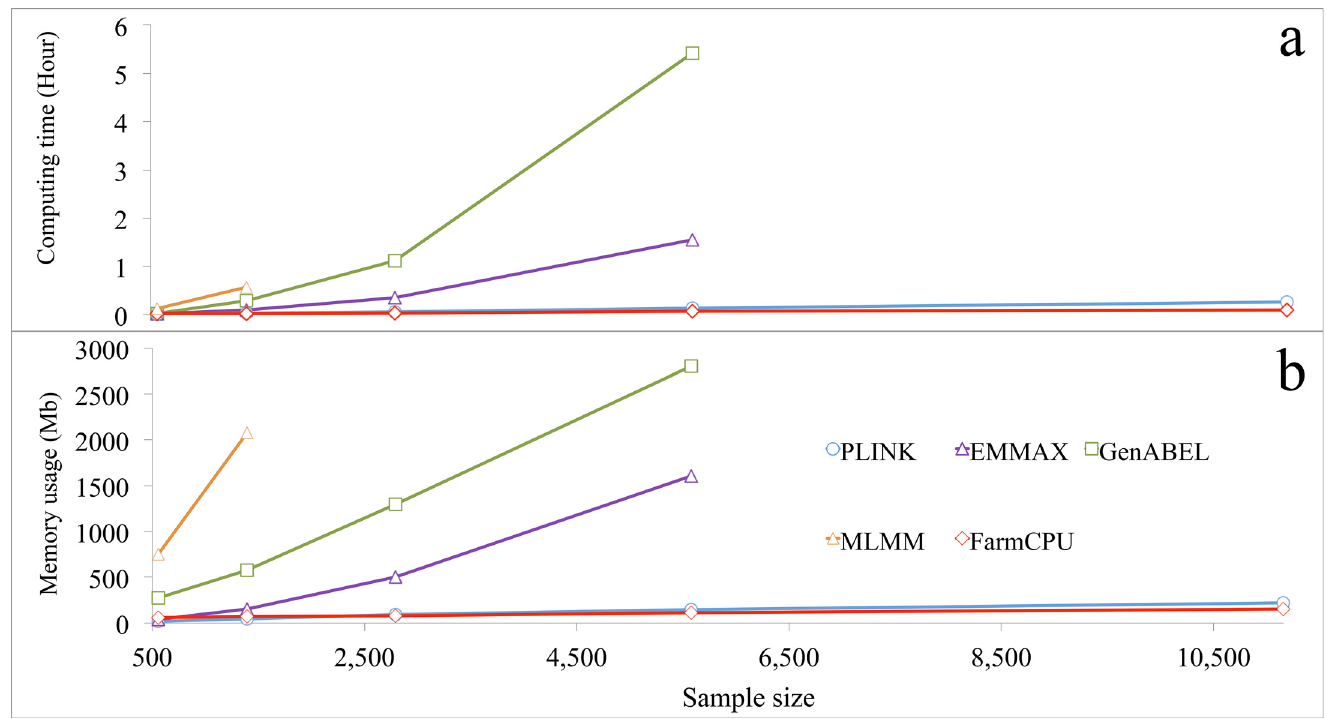
Fig 6. Computing time and memory usage of five software packages. Three statistical models were performed by the five packages: 1) GLM by PLINK; 2) MLMs by EMMAX, GenABEL, and MLMM; and 3) FarmCPU by FarmCPU. Computing time (a) and memory usage (b) in response to sample size are displayed. The analyses were performed on a laptop (Asus A53S) running a Linux system (Ubuntu 12.10, 64 bit) with a 4.0 Gb of Random-Access Memory (RAM) and an Inter duo Core i3-2310M processor at 2.1 GHz. One core was used for this test. All datasets had 60,000 markers, but response was measured as a function of sample size. The last data point indicates the maximum sample size each software package could process without freezing the computer, except for PLINK and FarmCPU. The limitations for these two software packages were not reached with the maximum sample size examined.